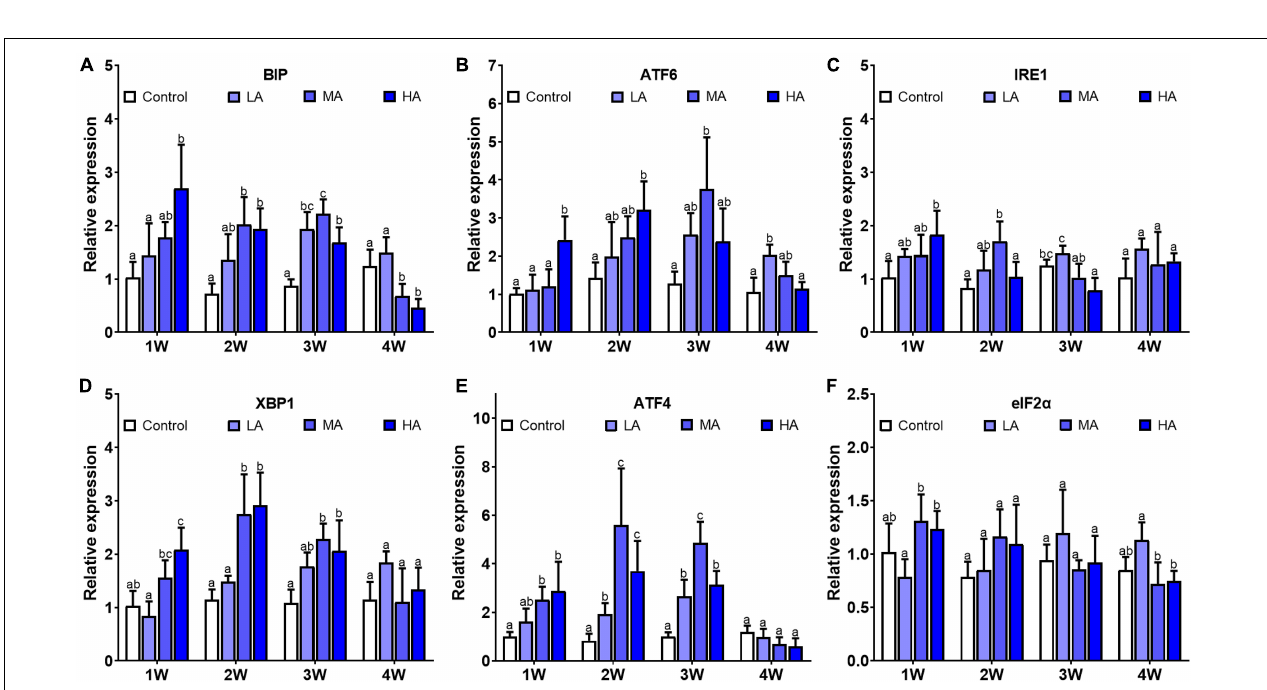
FIGURE 5 | Expression of BIP (A) , ATF-6 (B) , IRE1 (C) , XBP1 (D) , ATF-4 (E) , and eIF2 α (F) in different treatments during long-term ammonia stress. Values are means ± S.D ( n = 3). Different letters represent significant differences among different groups ( P < 0.05).